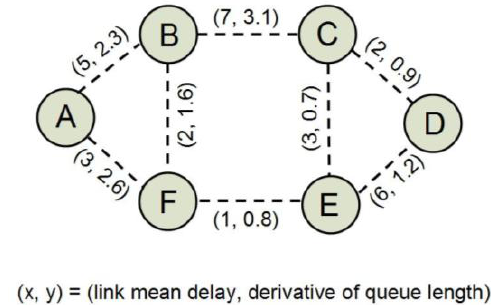
Figure A3. Simple networks with weight information of each link.